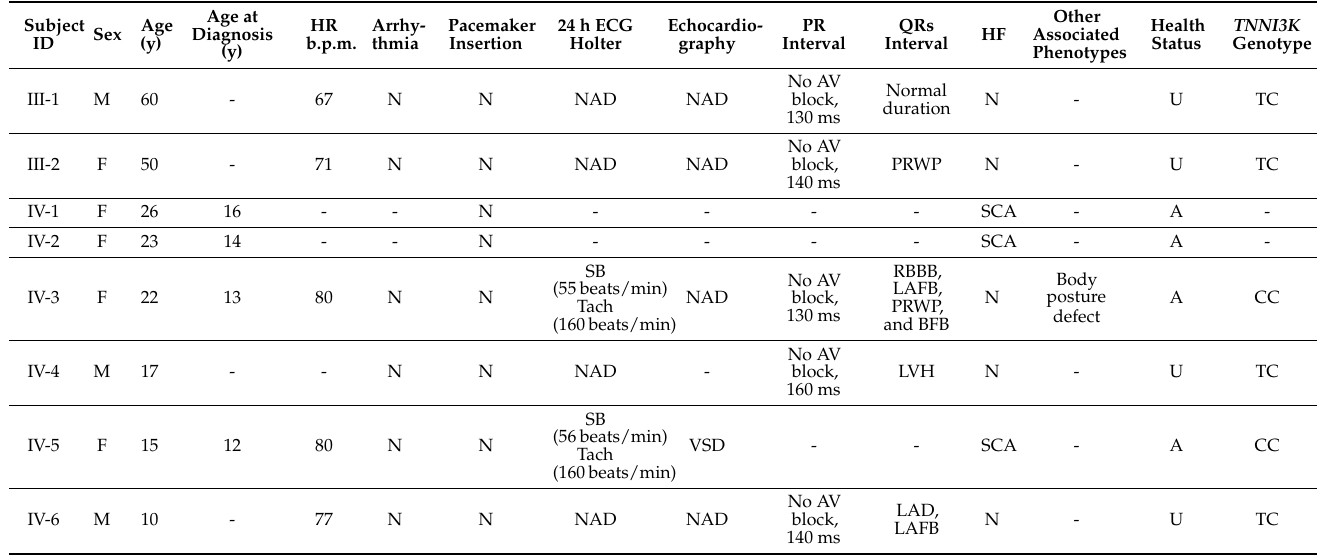
Table 1. Clinical Details of the Family with Cardiac Conduction Disease